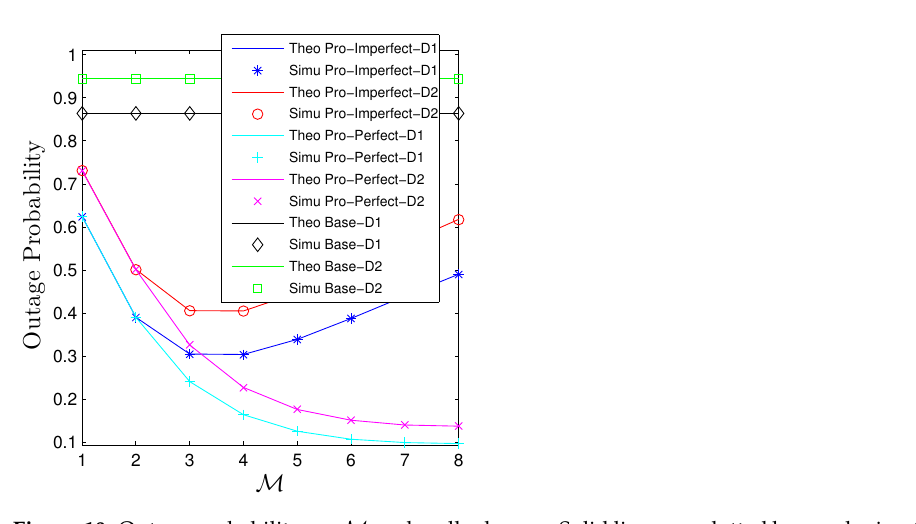
Figure 10. Outage probability vs. M under all schemes. Solid lines are plotted by employing (15)–(17) while markers are Monte Carlo simulation.